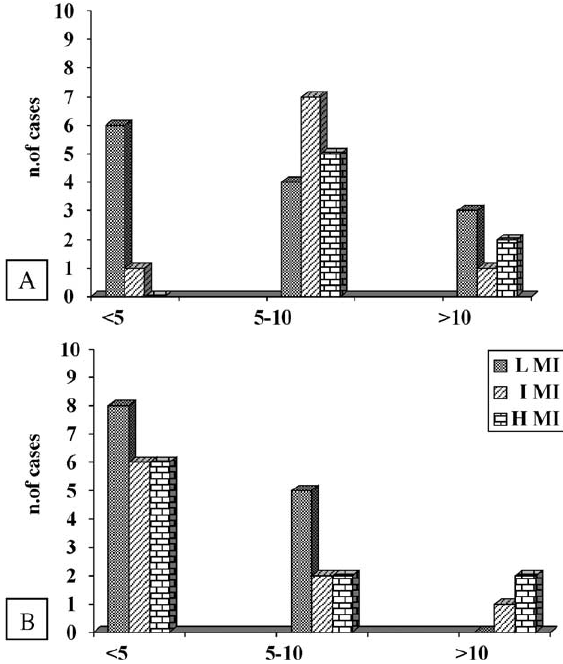
Fig. 4. Distribution of CD31 (A) and CD34 (B) in Clark’s level III–V melanoma cells in relation to Mitotic Index (L = Low, I = Interme- diate, H = High MI; < 5, 5–10, > 10: CD31 and CD34 immunohis- tochemical scoring.)